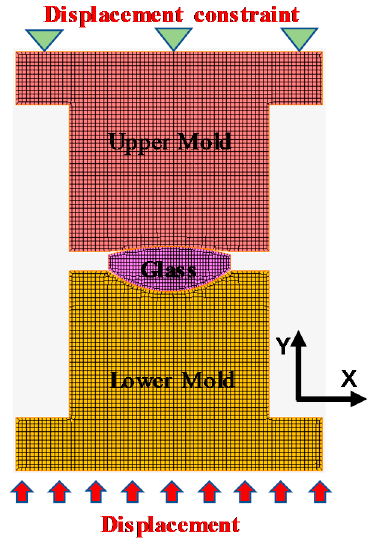
Figure 13. The simulation model of glass aspheric lens molding.